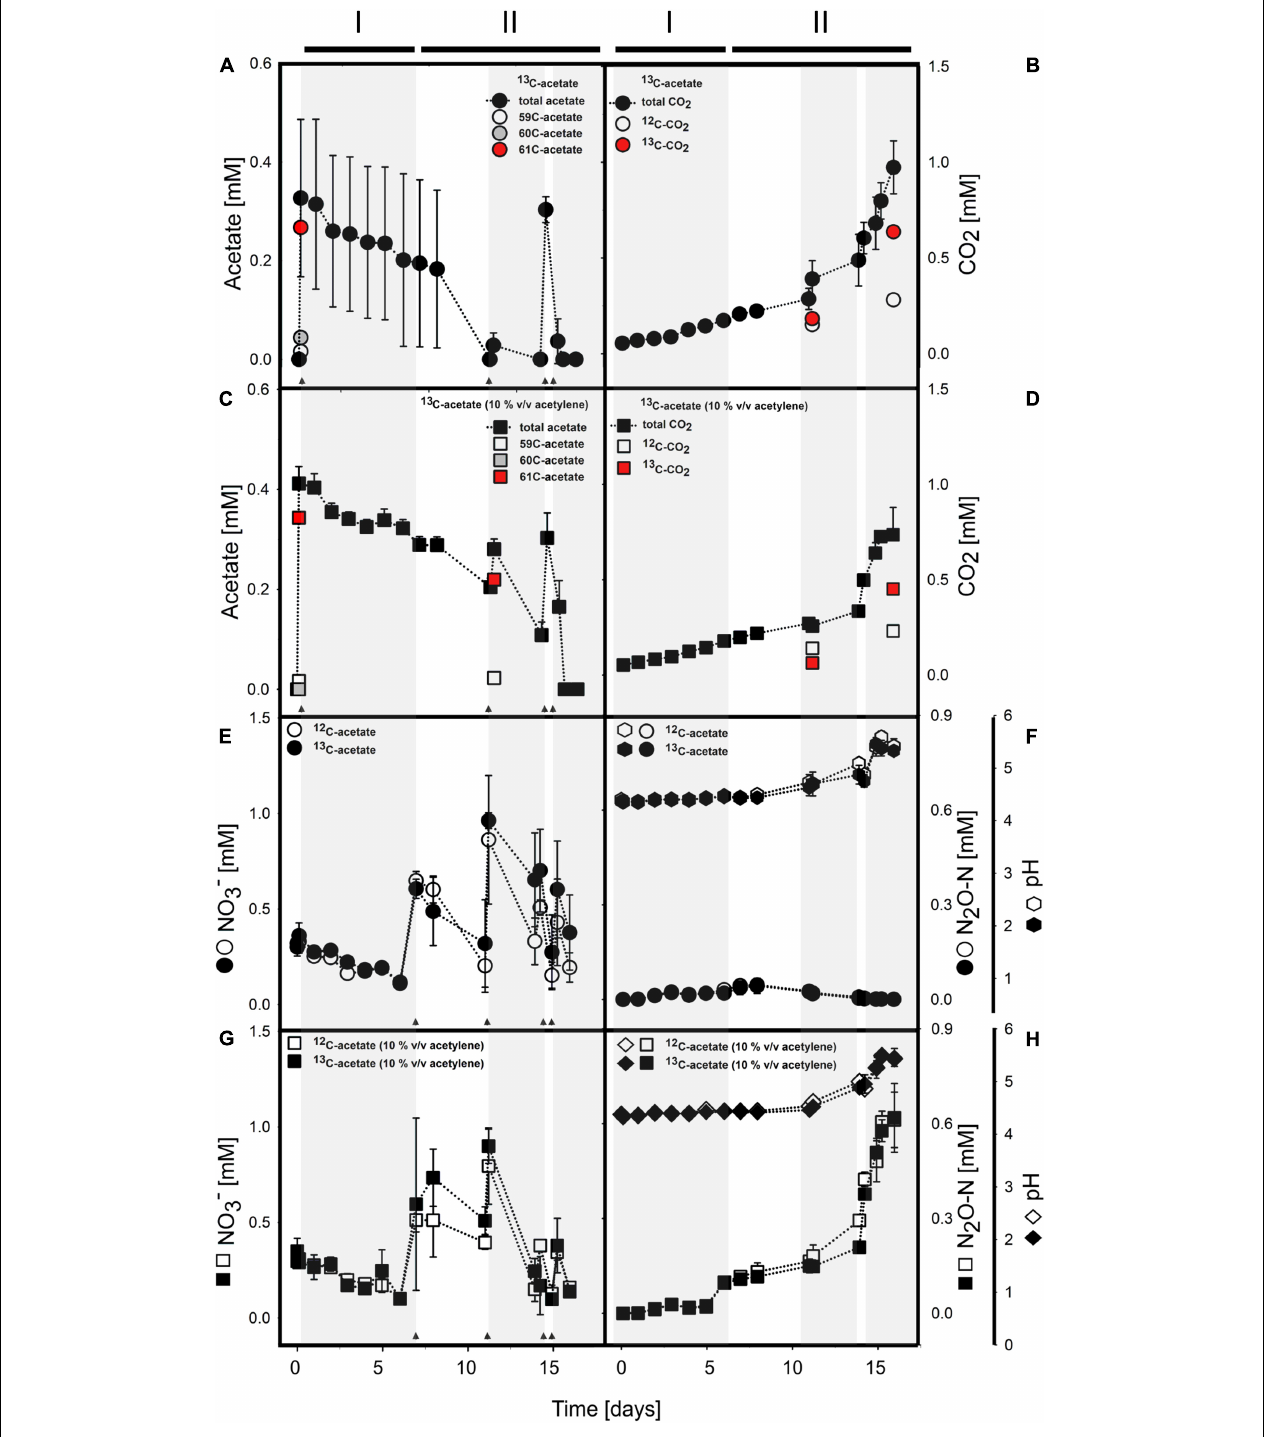
FIGURE 1 | Acetate (A,C) and nitrate (E,G) consumption concomitant to CO 2 (B,D) and N 2 O (F,H) production in anoxic incubations of acetate supplemented cryoturbated peat circle sediments without (A,B,E,F) and with (C,D,G,H) acetylene. pH is shown in panels (F) and (H) . Arrows indicate time of acetate or nitrate supplementation. Shaded and non-shaded areas highlight different periods of nitrate consumption, and lines above the graphs indicate phases (see Table 2 ). (A–D) show 13 C-acetate treatments only. For details on acetate and CO 2 in 12 C-acetate treatments, please refer to Supplementary Figure S1 . (E–H) include data of 13 C- and 12 C-acetate treatments as indicated in the insert. 59C-acetate, unlabeled 12 C 2 -acetate; 60C-acetate, half-labeled 13 C 1 -acetate; and 61C-acetate, fully labeled 13 C 2 -acetate. Values are means ± standard deviation of triplicate incubations except for isotope analyses where 1-3 values were obtained (see text for details).